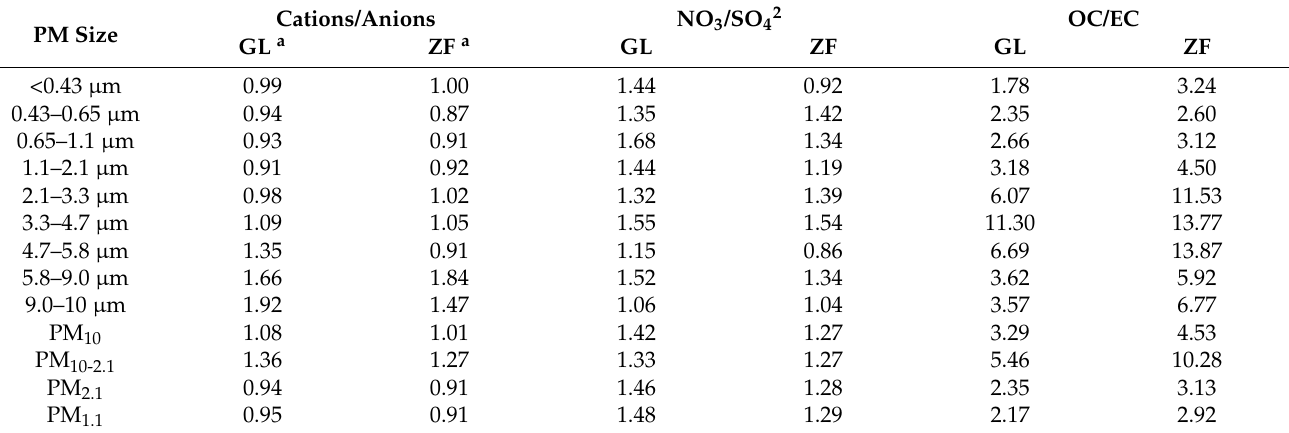
Table 4. The average ratios of cations/anions, NO 3 − /SO 42 − , and OC/EC for size-fractionated